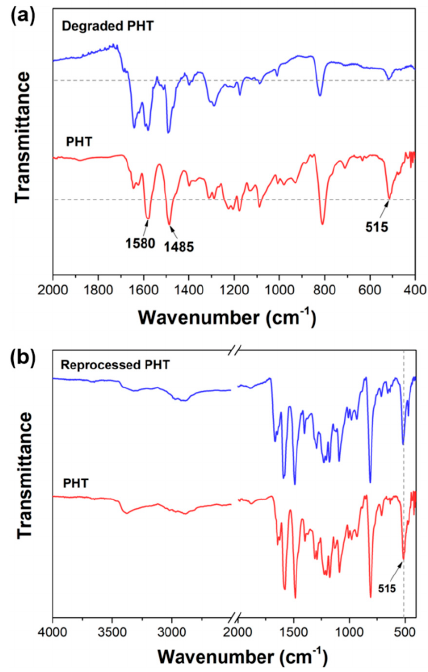
Figure 5. ( a ) FTIR spectra of the PHT and PHT residue after heating at 200 °C. ( b ) FTIR spectra of the PHT and reprocessed PHT after the hot-press treatment at 150 °C.